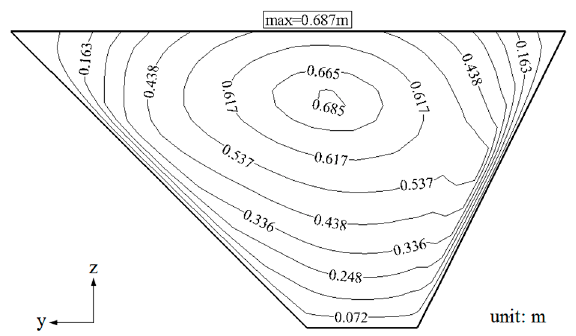
Figure 18. Flexural deformation contours of SACC ( h =200 m) .